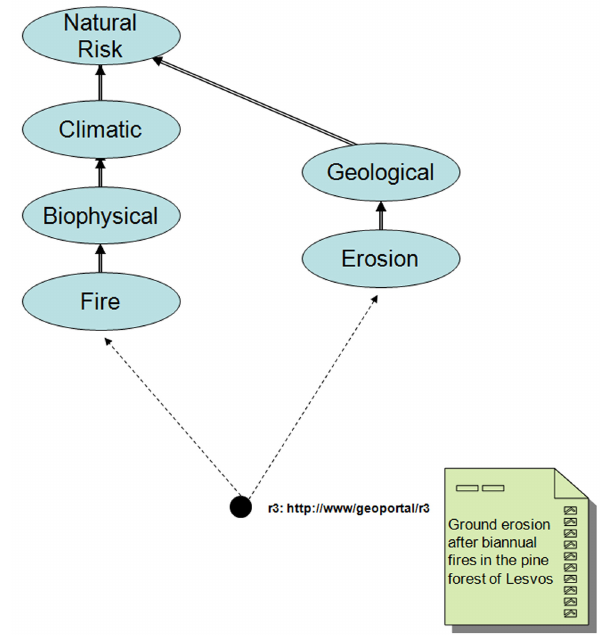
Fig. 12. Multiple classification of resources in the OntoFire ontol-